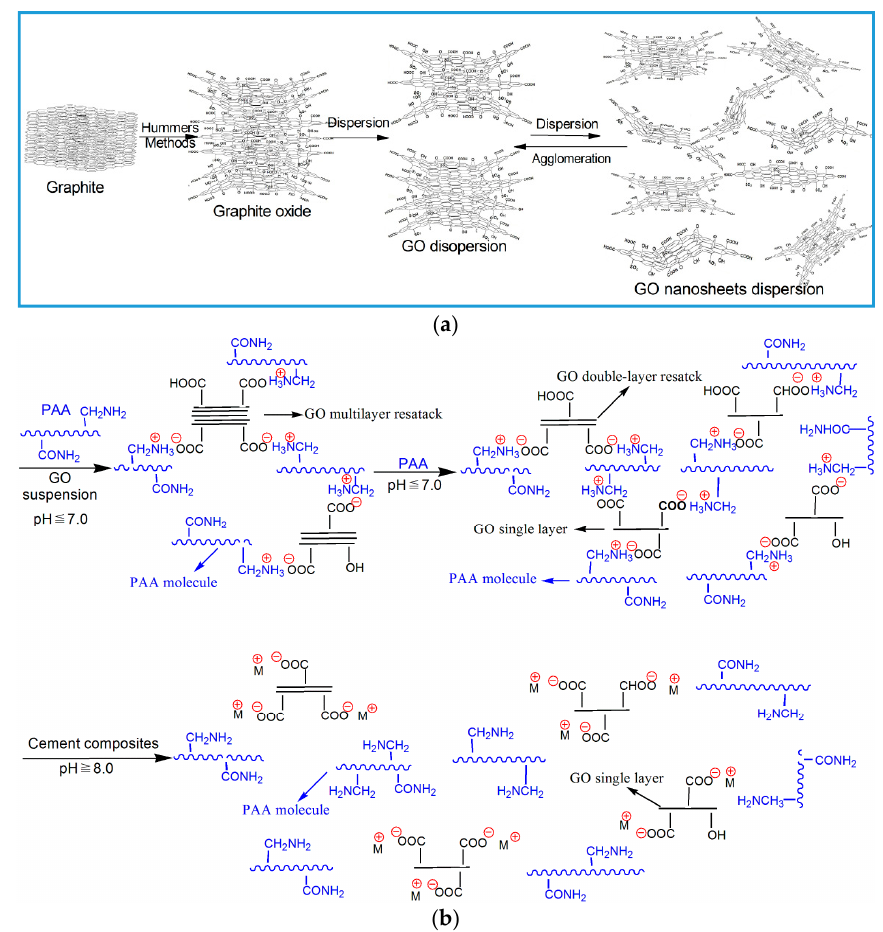
Figure 6. Schematic diagram of the dispersing mechanism of GO nanosheets with PAA. ( a ) Original GO nanosheet suspension; ( b ) Dispersing mechanism of GO nanosheets with